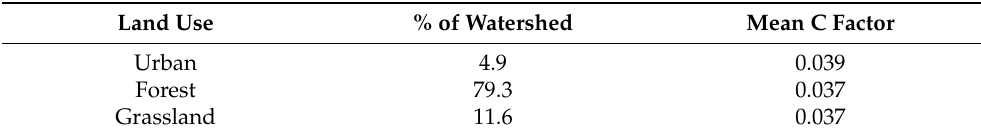
Table 7. Mean C Factor and area percentage of watershed per land use. Land Use % of Watershed Mean C Factor Urban 4.9 0.039 Forest 79.3 0.037 Grassland 11.6